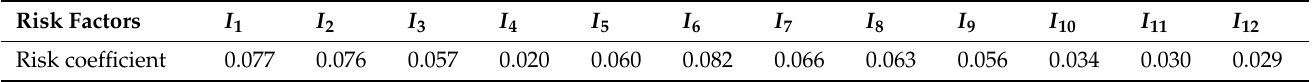
Table 16. Risk coefficient for risk